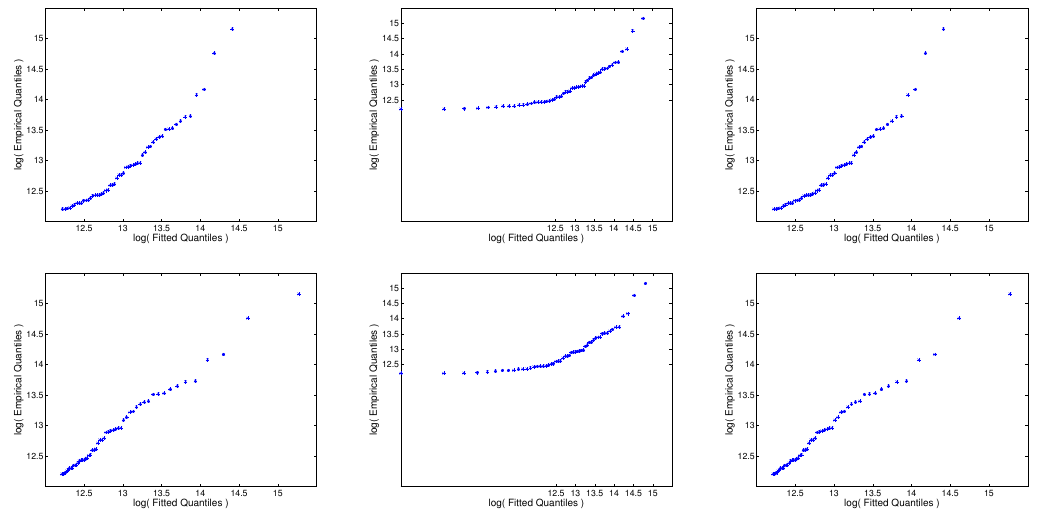
Figure 2. Fitted-versus-observed log -losses for exponential ( top row ) and Lomax ( bottom row ) distributions, using truncated ( left ), naive ( middle ), and shifted ( right ) approaches.